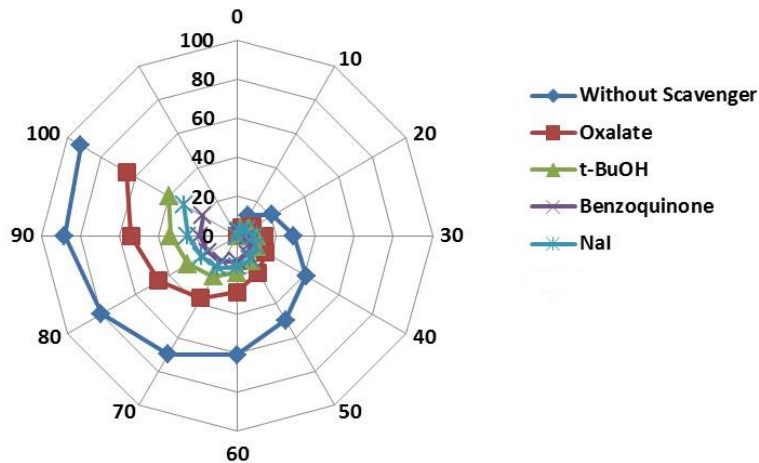
Fig. 12. Effects of adding I − , benzoquinone, butanol, and oxalate ions on the decolorization of 10 mg/L Yellow 5 (Yb